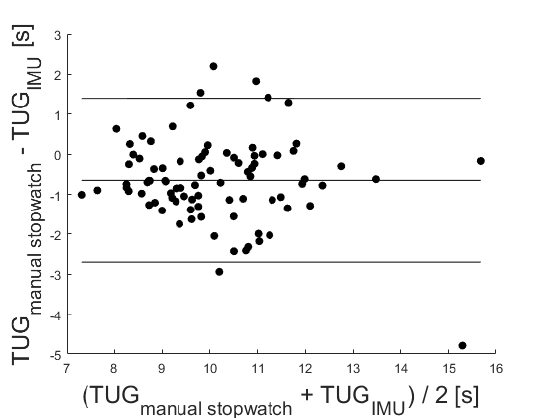
Figure 8. Corresponding Bland–Altman plot. Included levels indicate mean Diff ± 1.96 SD ( − 2.70 to 1.40